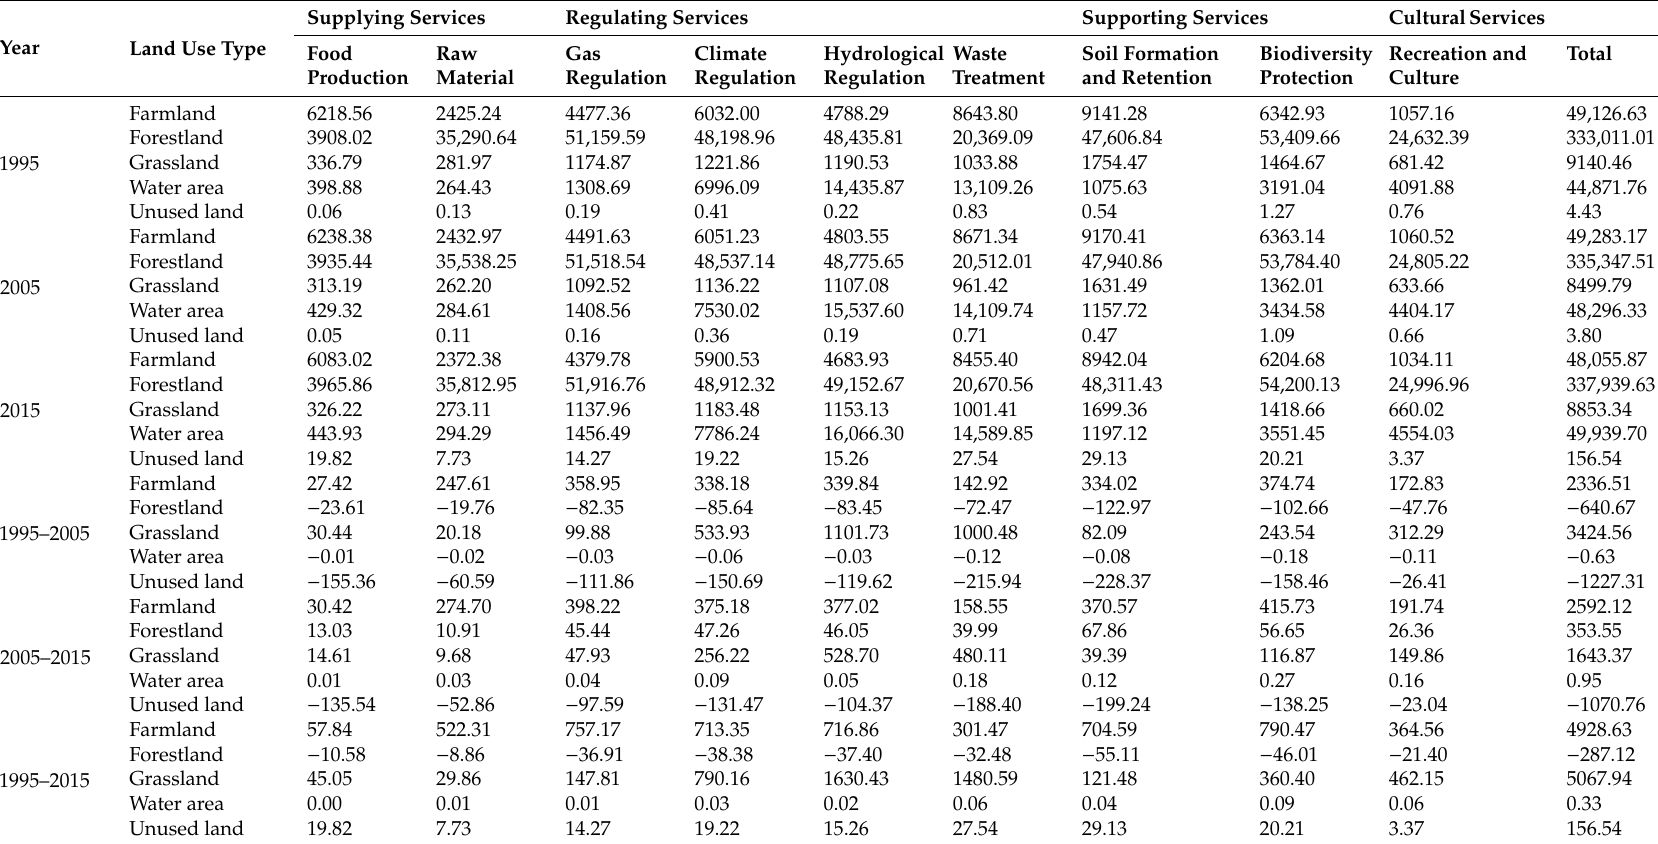
Table 3. Ecosystem services value (ESVs) of di ff erent land-use types from 1995 to 2015 (million